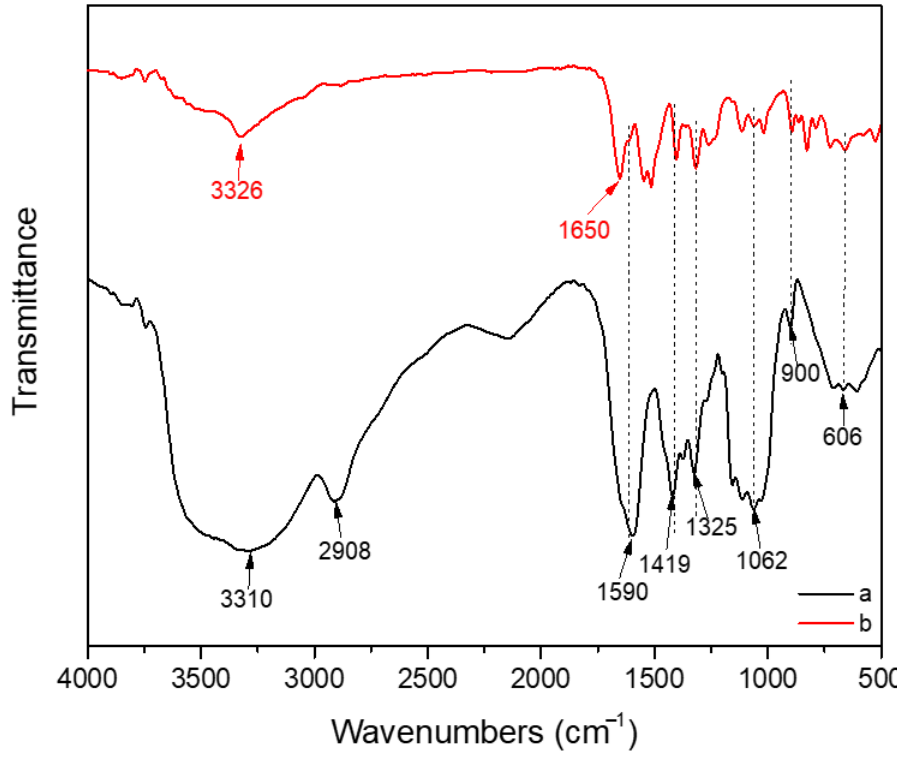
Figure 1. FT-IR spectra of (a) pure CCNF porous sample and (b) CCNF/ANF porous sample. SEM images of the pure CCNF porous sample and the CCNF/ANF porous sample are displayed in Figures 2 and 3, respectively. For CCNF/ANF-0 samples, a representative porous structure can be seen, and a relatively regular honeycomb appears. The section of the porous composite is approximately a rectangle, not a circle, with dimensions of approx- imately 200 µ m. The mutually independent rectangular sections may originate from the cylindric ice template under 0 ◦ C. After sublimation removal of the ice template, adjacent CCNF walls pull on each other and result in a tiny shape deformation. Furthermore, the disappearing ice templates retain longer internal passages, which is an advantage for gas flow and adsorption. The CCNF walls are slippery with little wrinkles. In Figure 2c,d, high- resolution section images indicate that the CCNF walls are constructed by a large number of cellulose filaments arranged in neat rows, demonstrating an excellent accumulation of hydrogen bonds. The thickness of the CCNF wall is approximately 1.5 µ m, and the single CCNF diameter is below 10 nm. In addition, the EDS test of CCNF samples indicates that the weight ratio of C and O is 47.89/52.11, without other